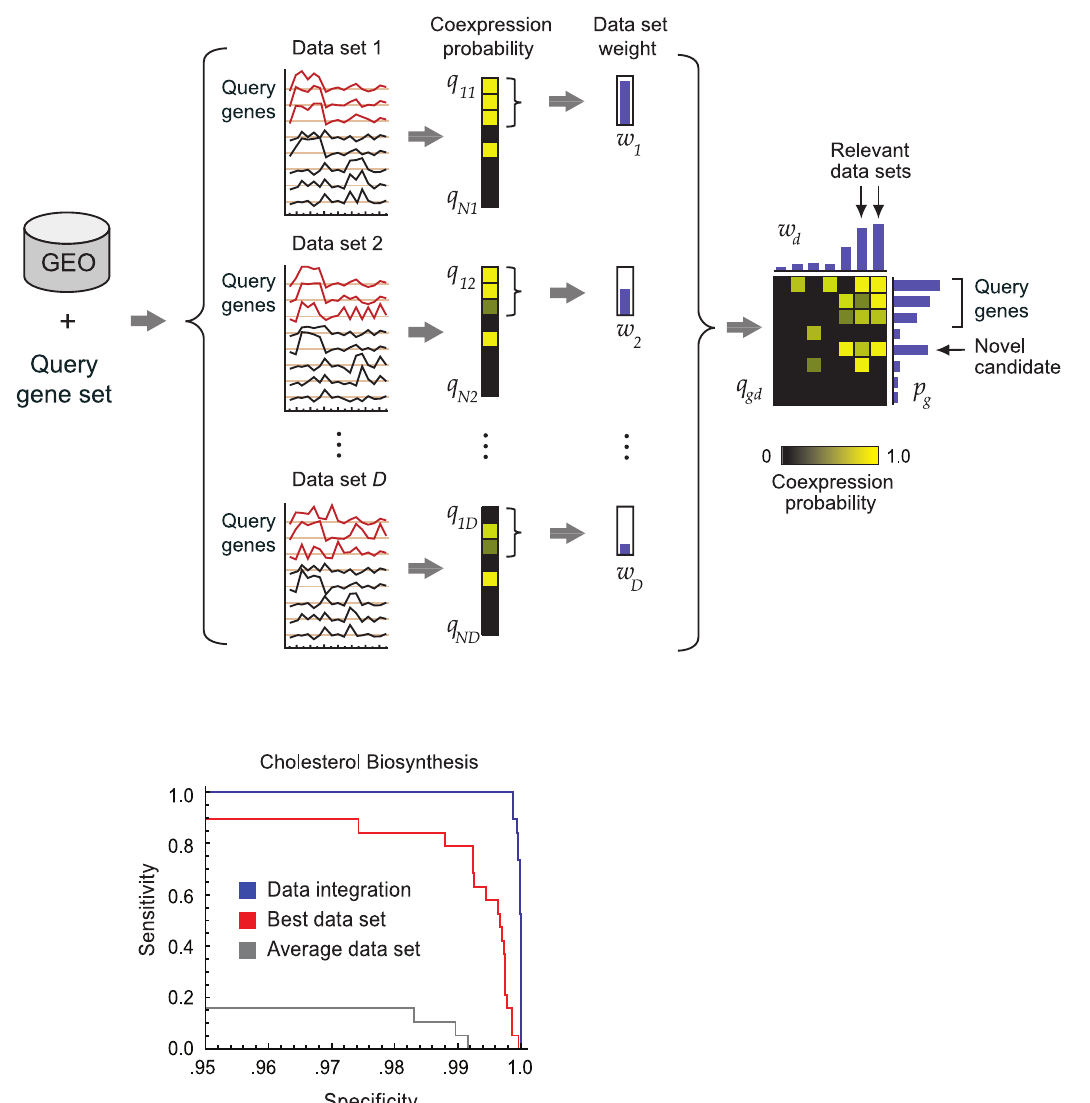
Figure 1. Overview and validation of expression screening. (A) Given a set of transcriptionally regulated genes as input (query gene set), expression screening interrogates a compendium of D microarray data sets (GEO) to produce a matrix of probabilities q gd of co-expression with the query genes for each of N genes (rows) measured in D data sets (columns). Each data set is assigned a weight, w d (vertical bars), according to the intra-correlation of the query gene set. A robust Bayesian data integration procedure is used to compute an integrated probability p g of co- expression for each gene (horizontal bars). (B) Cross-validated receiver-operator curve reporting the recovery of the query cholesterol biosynthesis gene set. Blue line: full expression screen data integration (1,427 data sets). Red line: the single best data set. Gray line: a data set with median